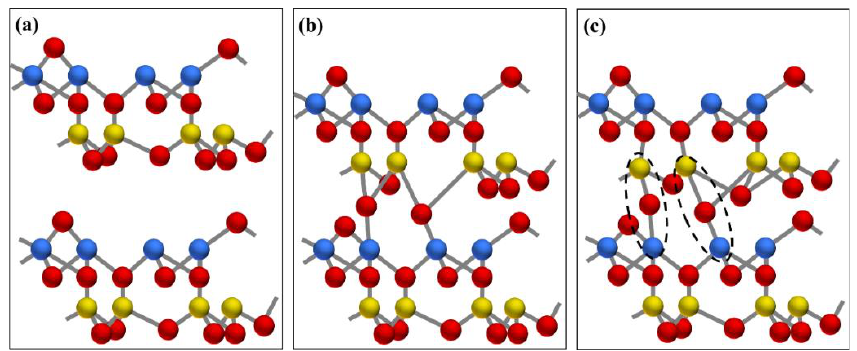
Figure 9. Schematic diagram of sintering between layers of metakaolinite: ( a ) layer structure of metakaolinite, ( b ) a high-energy transition state with an overcoordinated Si atom and Al−O bond dissociation, ( c ) a sintered structure with interlayer Al−O−Si bonds . Al, Si, and O atoms are represented by yellow, blue, and red spheres, respectively.